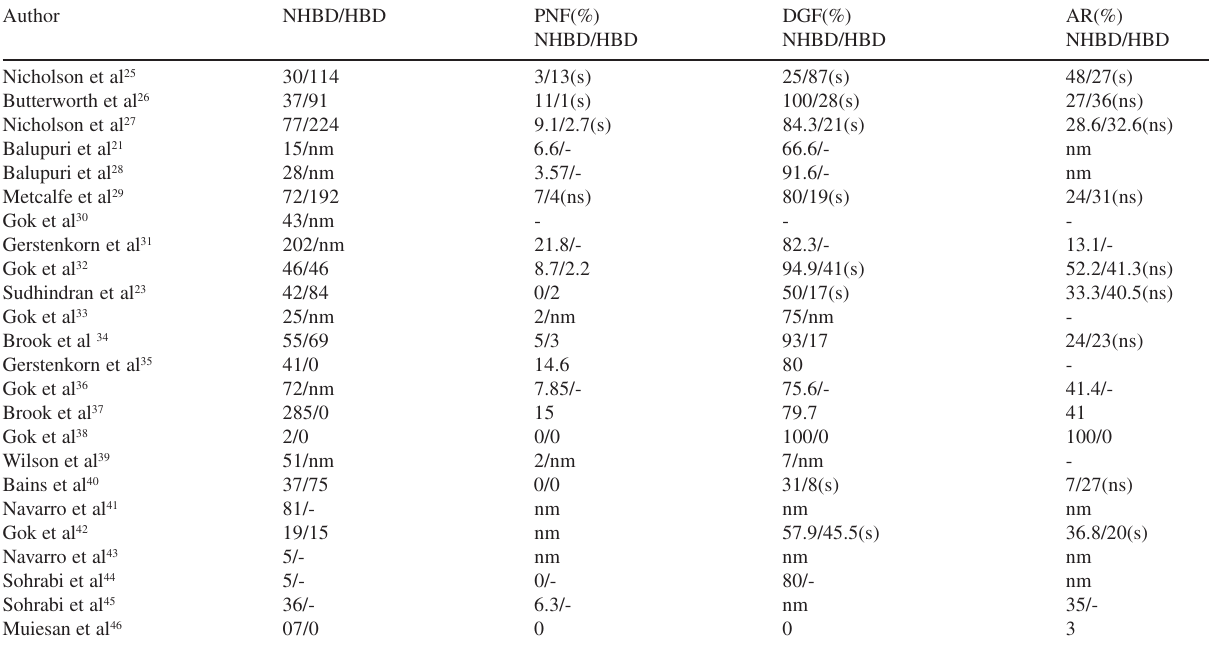
Table 7 - Comparation of the results of NHBD/HBD in England relating to primary non-function, delayed graft function and acute rejection.